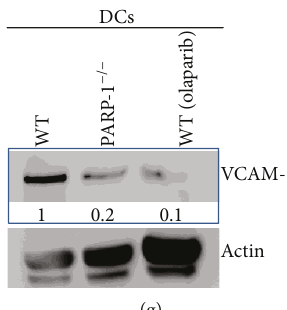
Figure 4: (a) Lung sections from OVA-sensitized and OVA-challenged WT or PARP-1 − / − mice were subjected to immunohistochemistry with antibodies to mouse VCAM-1; bar: 50 μ m. Immunoreactivity was assessed using the Image-Pro software. Results are mean ± SD of immunoreactivity signals expressed in arbitrary units; ∗∗∗ p ≤ 0 001 . (b) PARP-1 − / − endothelial cells were transduced with an adenoviral vector encoding human PARP-1 or control virus. Protein extracts were subjected to immunoblot analysis with antibodies to PARP-1 or actin. (c) Cells from (b) were treated with 1 mg/ml LPS, 10 ng/ml TNF- α , or 10 ng/ml IL-1 β for 4 h. Total RNA was then prepared, reverse-transcribed, and ampli fi ed by PCR with primer sets (Supplemental Table 1) speci fi c to human PARP-1 , mouse VCAM-1 , mouse iNOS , or GAPDH. Amplicons were subjected to agarose electrophoresis. (d) Lung smooth muscle cells isolated from WT or PARP-1 − / − mice were subjected to increasing concentrations (0.01-1000ng/ml) of LPS for 4 h. Isolated RNA was then reverse-transcribed followed by PCR with primers to mouse VCAM-1 or β -actin. (e) WT or PARP-1 − / − smooth muscle cells were treated with 100ng/ml LPS mice and collected after 18 h. Protein extracts were subjected to immunoblot analysis with antibodies to VCAM-1 or actin. (f) PARP-1 − / − smooth muscle cells were transduced with the aforementioned adenoviral vectors after which cells were treated with LPS and collected 18h later. Protein extracts were subjected to immunoblot analysis with antibodies to PARP-1, VCAM-1, or actin. (g) Protein extracts from di ff erentiated WT, PARP-1 − / − , or olaparib-treated WT DCs were subjected to immunoblot analysis with antibodies to VCAM-1 or actin. For (e – g), signals were quanti fi ed and are shown as values under the respective